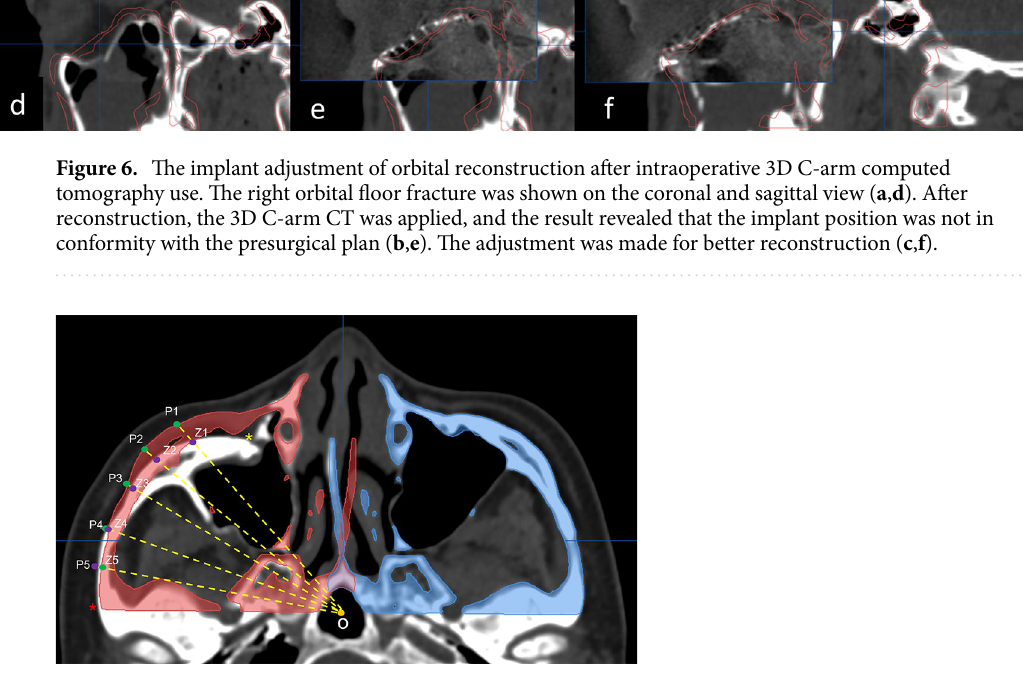
Figure 7. Measurements of zygoma conformity according to presurgical planning. The infraorbital foramen (yellow asterisk) and base of zygomatic arch (red asterisk) were identified on CT. The five points (Z1, Z2, Z3, Z4, and Z5) (violet points) on the zygomatic surface were defined and evenly distributed based on its angle of degree. The O point (yellow point) is defined as the intersection of the vertical midline and the horizontal line that passed through the bilateral zygoma arch base. The Z1O line (yellow dotted line) that intersected at the surface of the zygoma object during presurgical planning is defined as P1 (green point). The other points P2 to P5 (green points) are defined in the same manner. The preoperative and postoperative distances to virtual planning images between Z1 and P1, Z2 and P2, Z3 and P3, Z4 and P4, and Z5 and P5 were